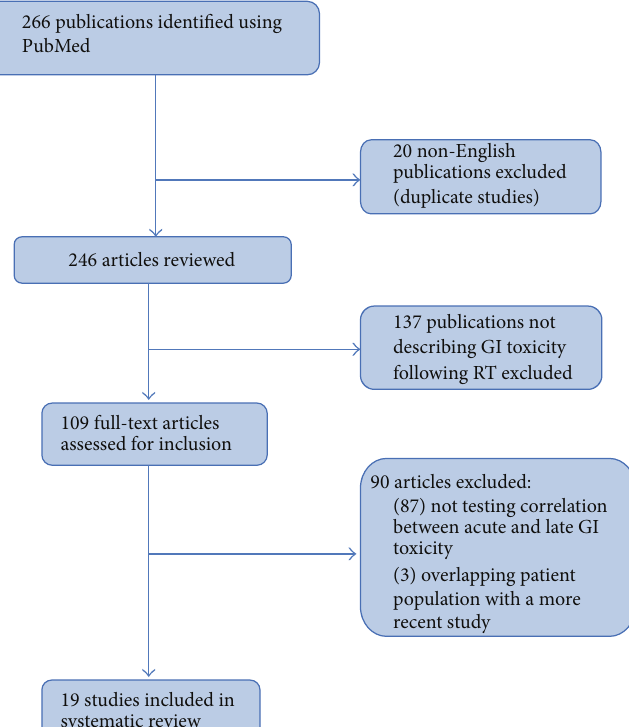
Figure 1: Selection strategy for systematic review of the published literature evaluating the relationship between acute and late gastrointestinal toxicity following prostate radiation